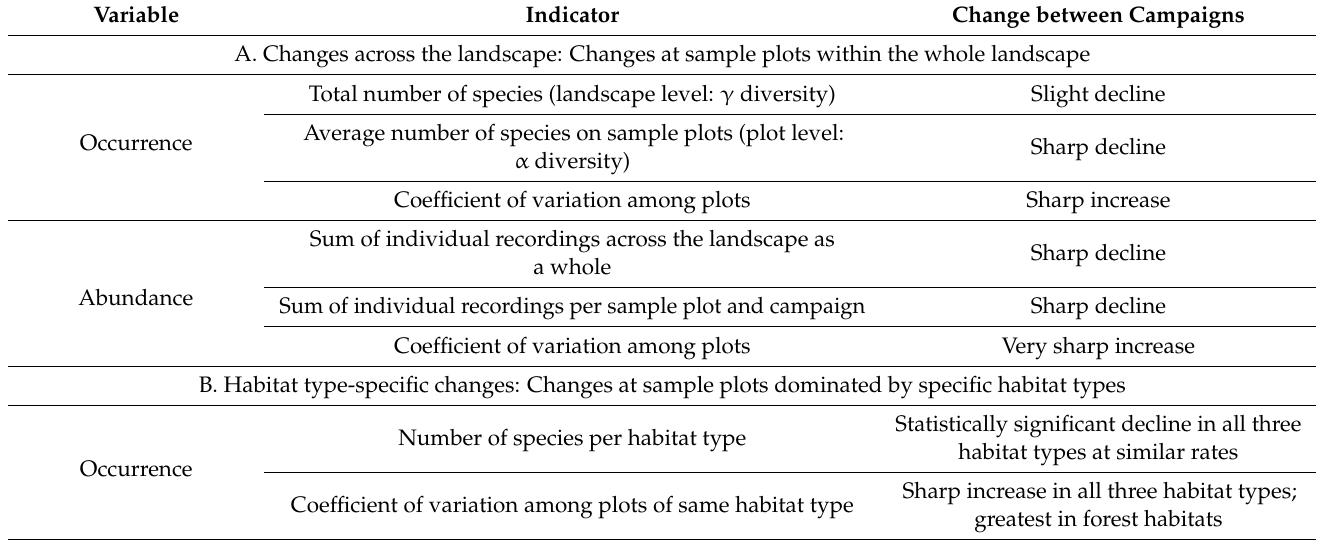
Table 5. Changes in bird community over 17 years (first campaign: 1999–2002; second campaign: 2013–2015) on multiple analytical foci and data aggregation levels. Indicator Change between